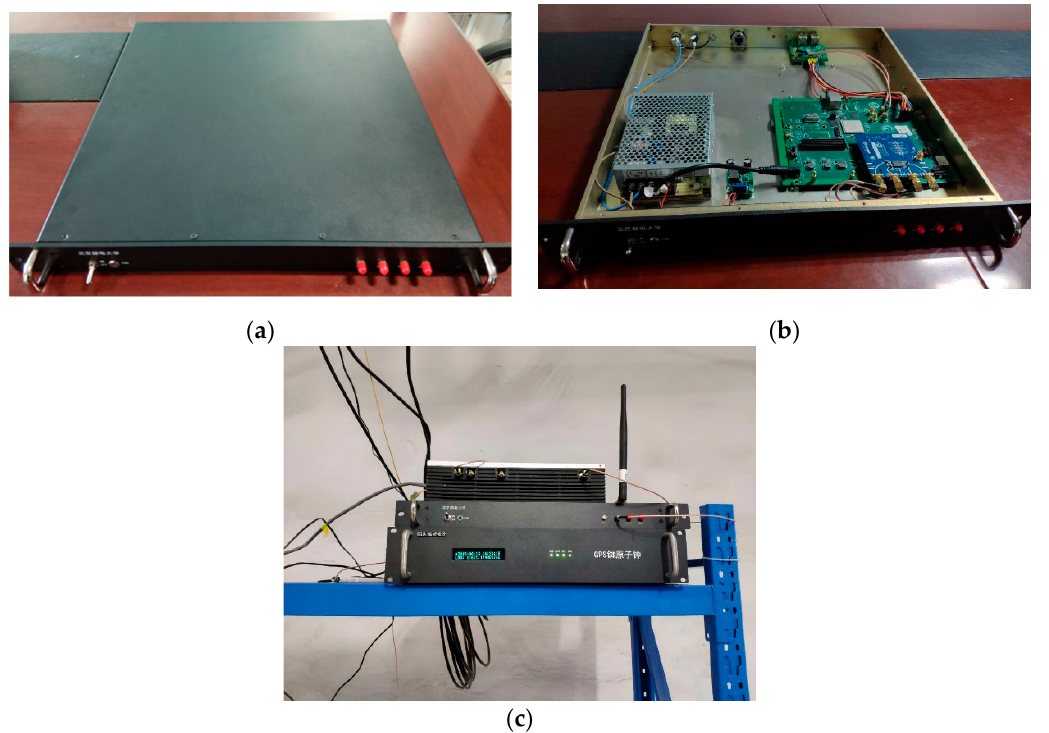
Figure 17. ( a ) External structure of FSBS positioning module; ( b ) internal structure of FSBS positioning module; ( c ) FSBS.